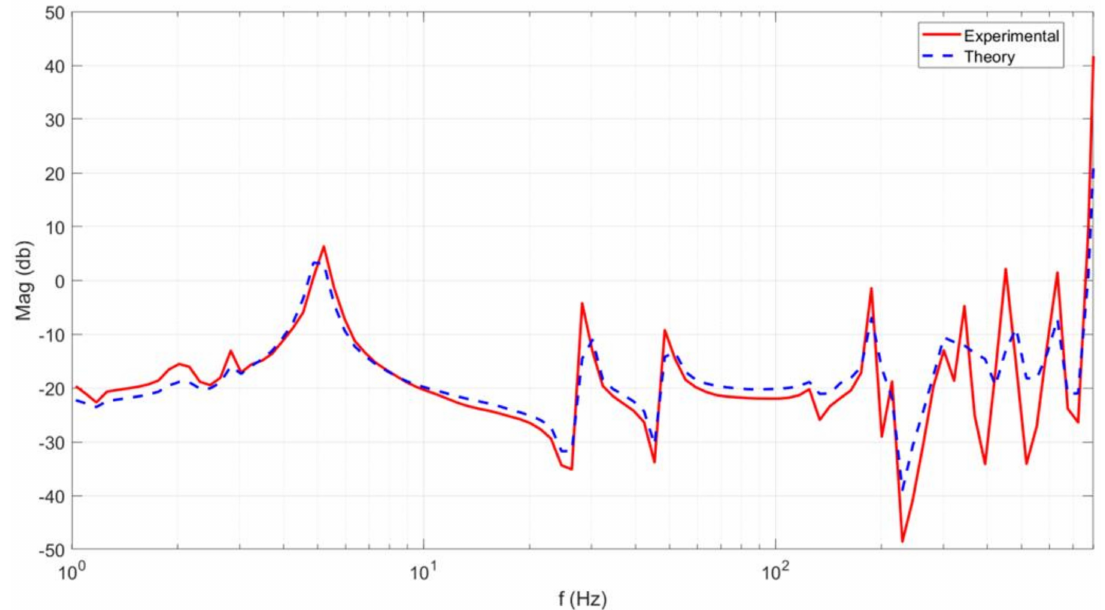
Figure 3. Comparisonoffrequencyresponsefunctionmagnitudeofthepartiallysubmergedplate(H=0.15m),theoryandexperiment.